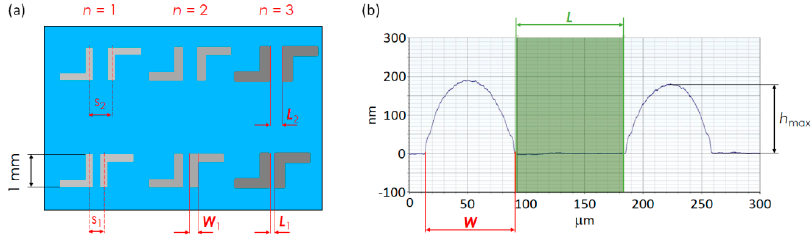
Figure 1. ( a ) Schematic top view representation of DGP overprints with various interline spacing ( s ) and different number of printing passes ( n ). ( b ) Exemplary cross-section profile underlining the geometrical parameters W , L and h max .